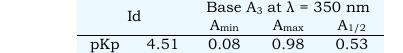
Table 3 Spectrophotometric determination of ionization and protonation constants of (A 3